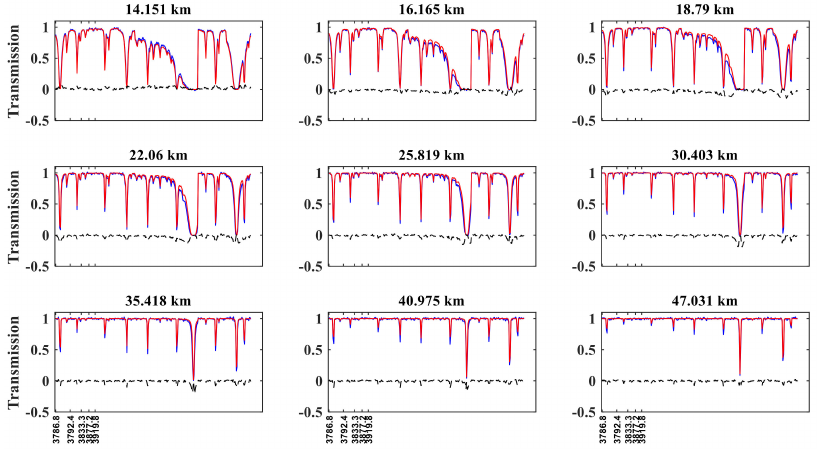
Figure 5. The same as Figure 3 but for